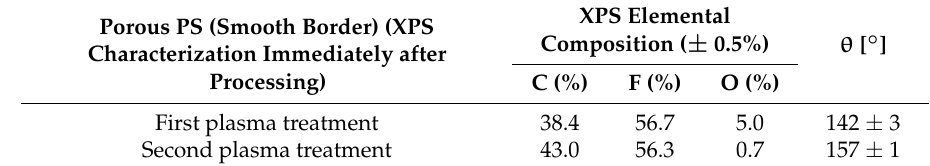
Table 1. Surface composition of the microporous PS with the smooth border and the corresponding water contact angles after the repeated plasma treatment. The smooth borders were prepared with five doses of 1.5 THF:8.5 ETH at 295 K. The power of the plasma reactor was 300 W. XPS Elemental Porous PS (Smooth Border) (XPS Composition ( ± 0.5%) θ [ ◦ ] Characterization Immediately after Processing) C (%) F (%) O (%) First plasma treatment 38.4 Second plasma treatment 43.0 157 ± 1